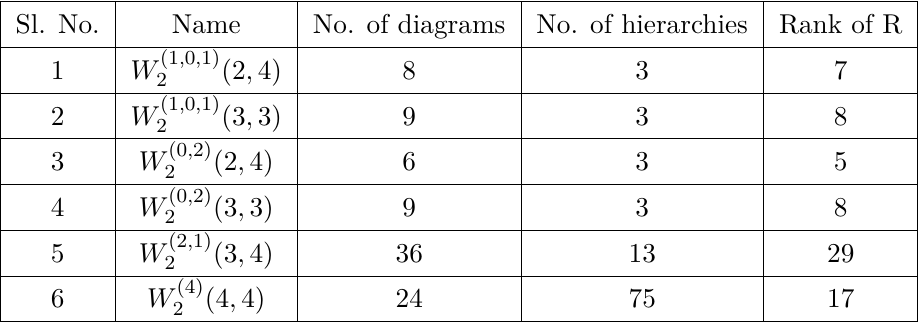
Table 4. Summary of the results for four-loop Cwebs connecting two Wilson